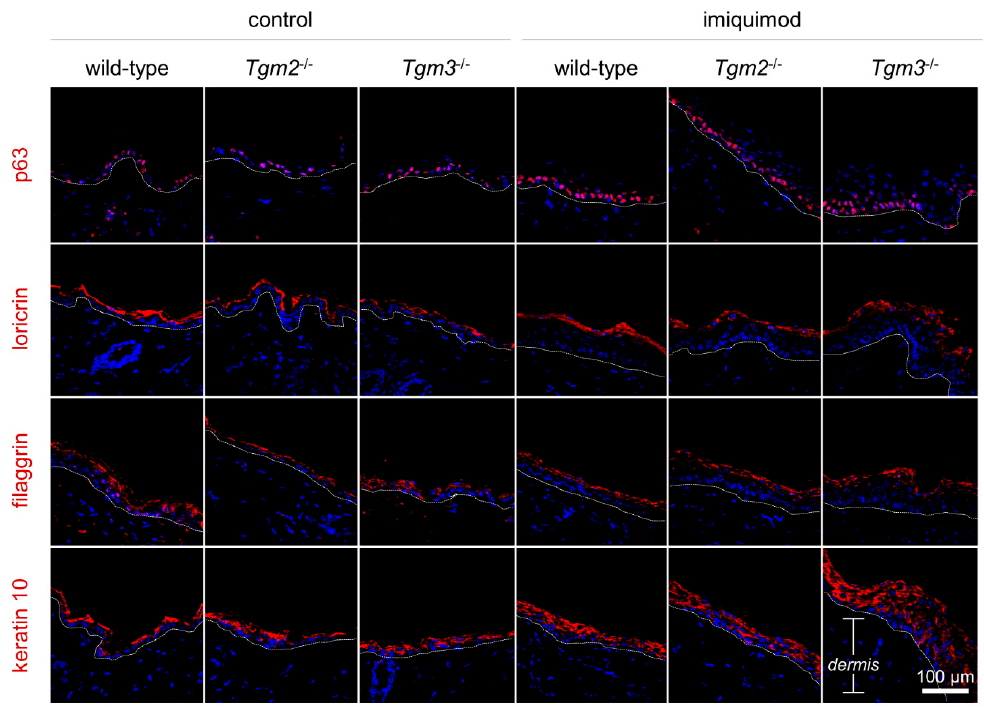
Figure 4. Imiquimod treatment leads to thickening of the spinous layer in the TG3KO mouse epidermis. Scale bar 100 µ M. Immunofluorescence analysis of p63, loricrin, filaggrin, and keratin 10 expression in the skin of either control or imiquimod-treated WT, TG2KO, and TG3KO mice.